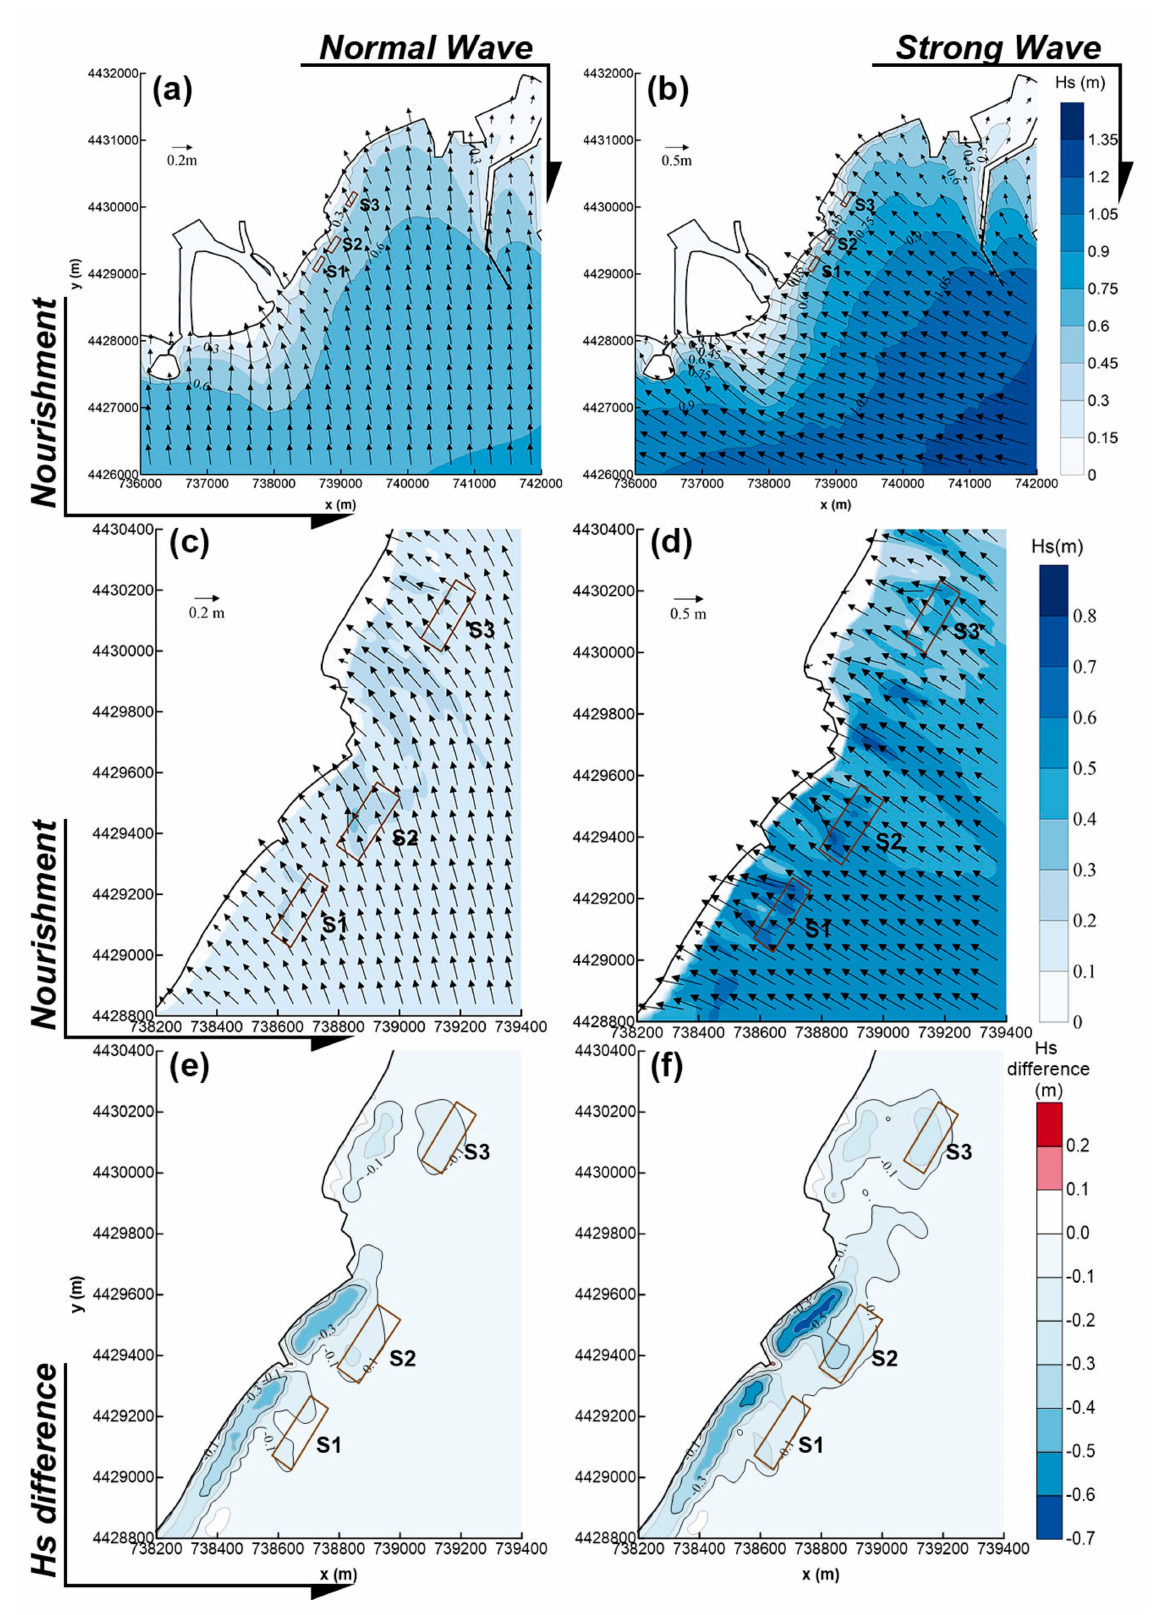
Figure 9. Spatial distributions of significant wave height (Hs) in scenario ( a , b ) with beach nourishment and ( c , d ) the zoom view of S1, S2, and S3 area, and the difference between scenarios with and without beach nourishment ( e , f ) under the normal wave and strong wave conditions, respectively. Red and blue patches represent increase and decrease of Hs